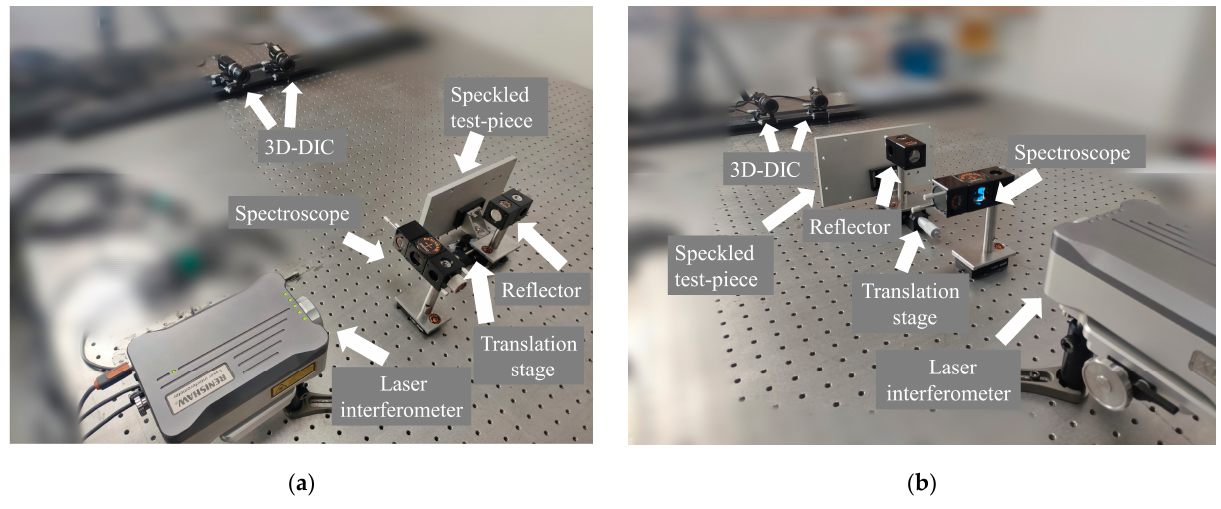
Figure 5. Displacement test system ( a ) in-plane displacement ( b ) out of plane displacement.